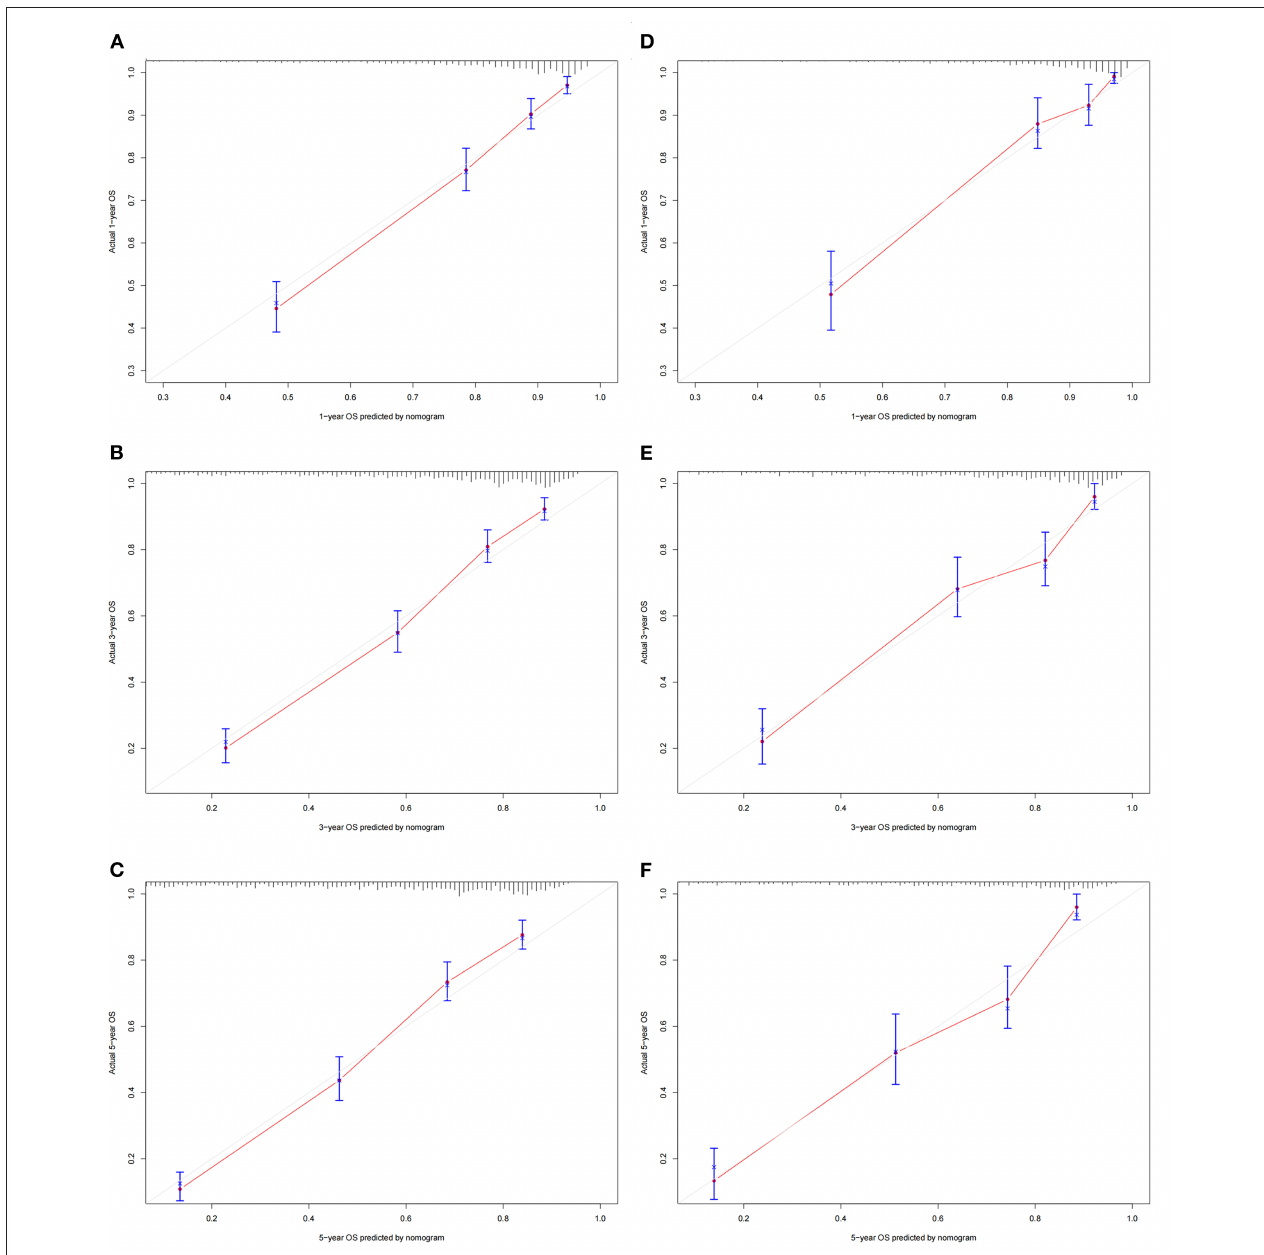
FIGURE 3 | Calibration curves of the nomogram. (A–C) For 1-, 3-, and 5-year OS in the training set; (D–F) For 1-, 3-, and 5-year OS in the validation set. The horizontal axis is the predicted value of the nomogram, and the vertical axis is the actual observed value of the nomogram. The coincidence between the predicted curve and the diagonal line means that the predicted value and the actual observed value are almost the